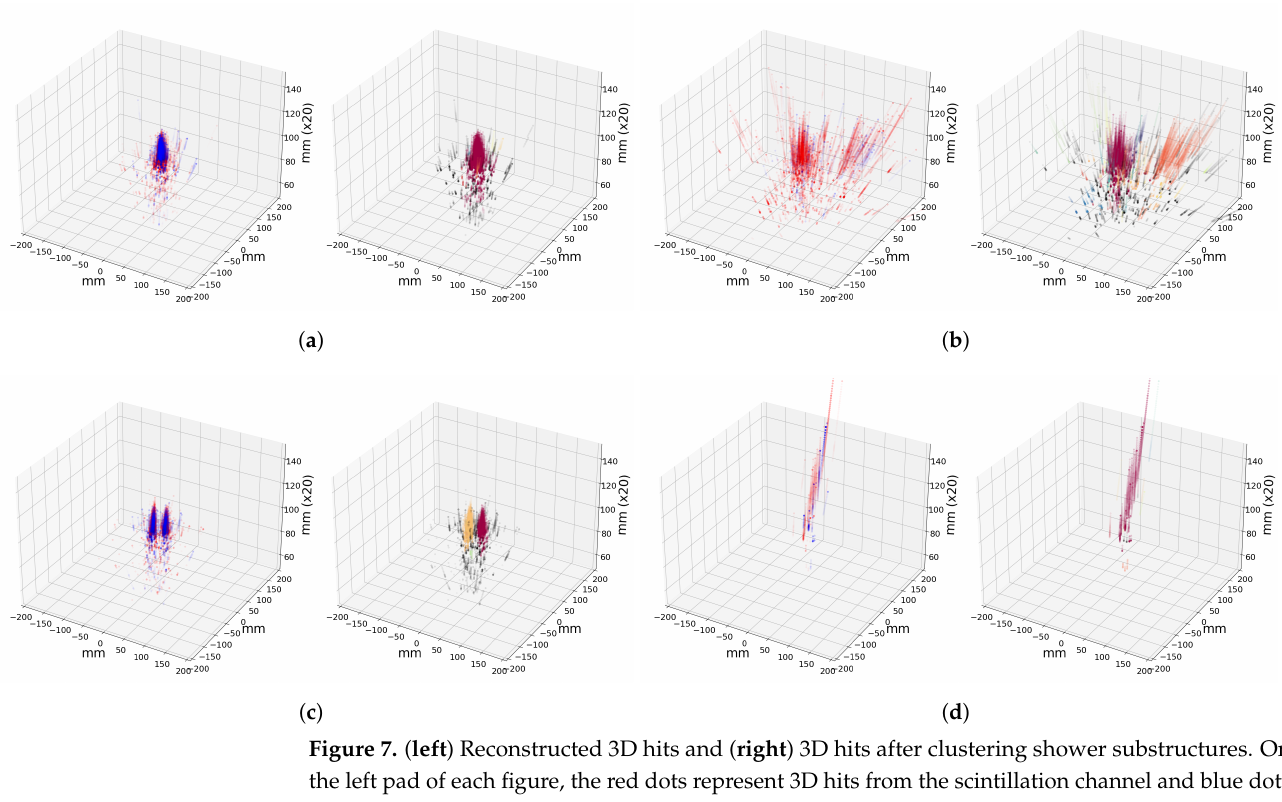
Figure 7. ( left ) Reconstructed 3D hits and ( right ) 3D hits after clustering shower substructures. On the left pad of each figure, the red dots represent 3D hits from the scintillation channel and blue dots from the Cherenkov channel. Color codes on the right pad illustrate different substructures clustered by the DBSCAN. The longitudinal (vertical) axis is scaled by 20, where a unit length equals 20 mm. ( a ) Electron. ( b ) Pion. ( c ) Neutral pion. ( d )